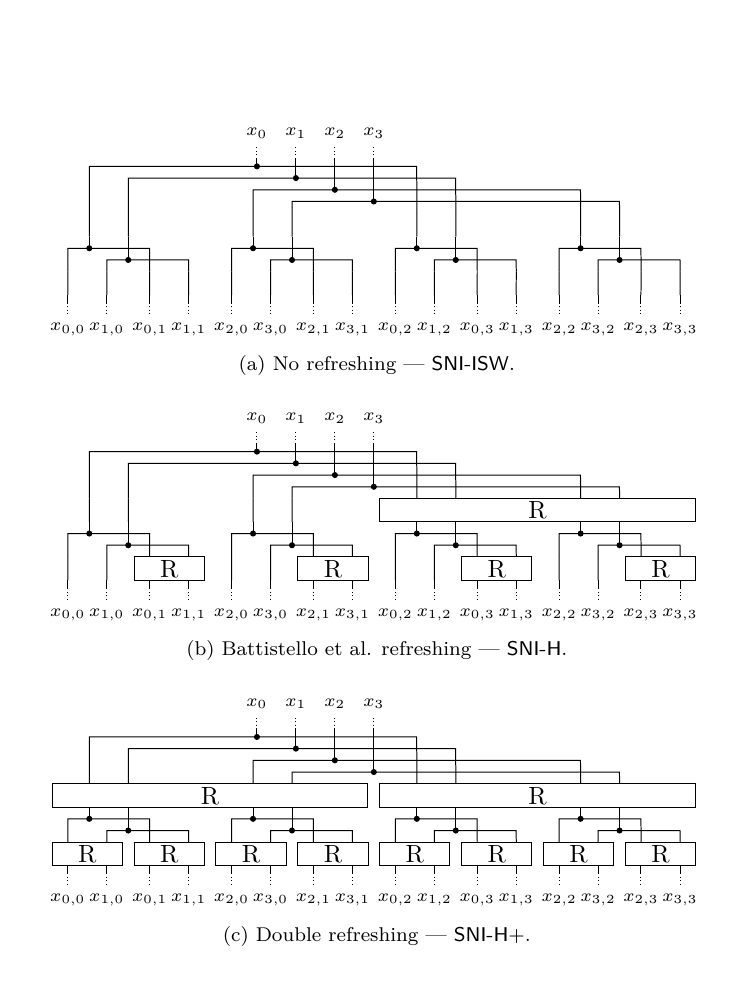
Figure 5: Exemplary instantiations of the generalized MatGen algorithm (Algorithm 2) for d = 4. The algorithm basically corresponds to two trees of internal refresh gadgets (one for sharings of x , one for those of y ). The input shares are x 0 , . . . , x 3 . The x i,j are the outputs of the MatGen stage (see Equation (1)).